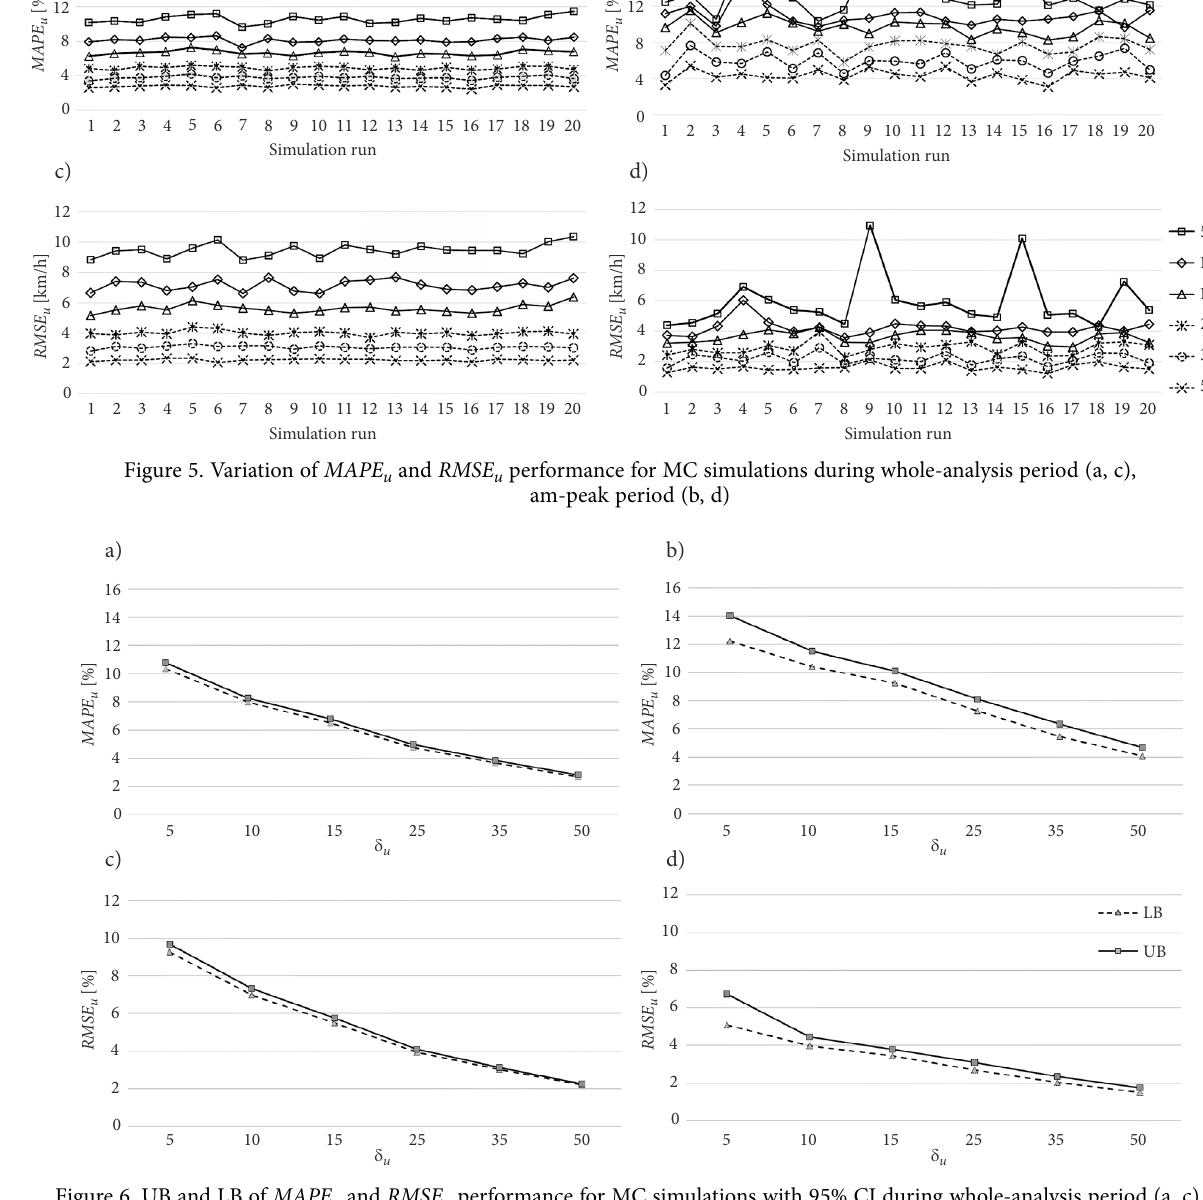
Figure 6. UB and LB of MAPE u and RMSE u performance for MC simulations with 95% CI during whole-analysis period (a, c), am-peak period (b,